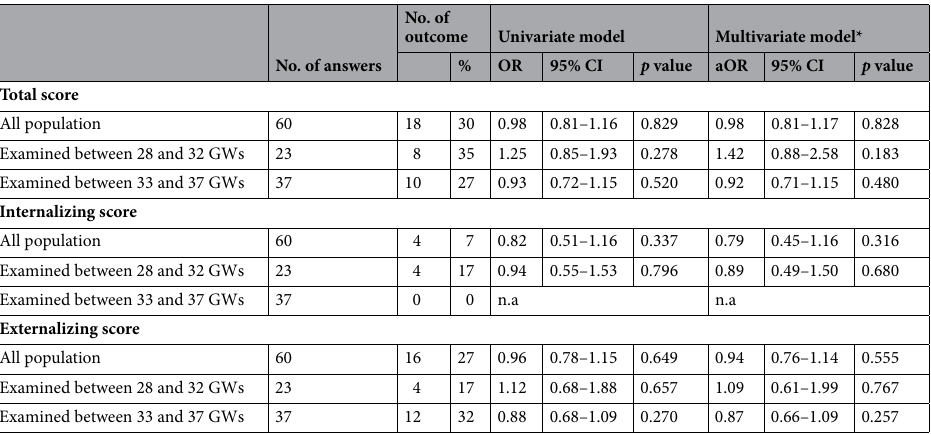
Table 3. Association between fetal EMD and infant CBCL abnormality. EMD, eye movement density; OR, odds ratio; aOR, adjusted odds ratio; CI, confidence interval; GWs, gestational weeks. *Adjusted for maternal age at delivery, parity, and child’s birth weight. **All ORs or aORs are per 1/min increasing fetal EMD.